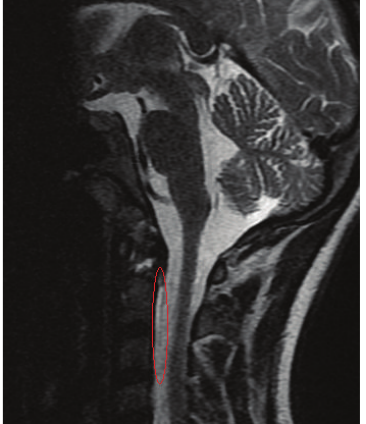
Figure 4: Sagittal MR reconstruction image shows narrow fluid compartment at the level of C2-C3 (marked), poor quality due to the stabilization of the